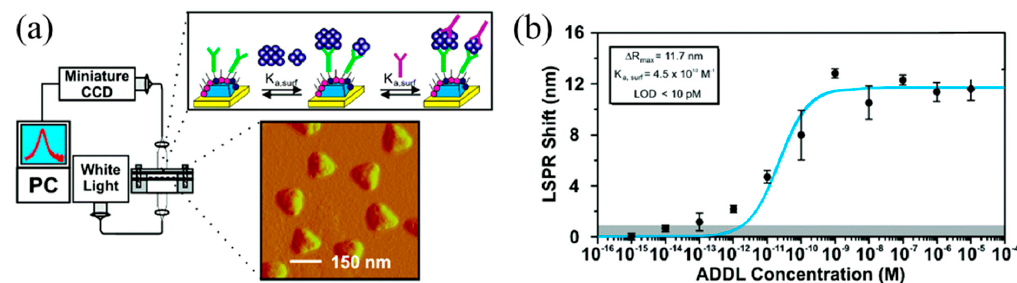
Figure 5. ( a ) Sketch and experimental setup for localized surface plasmon resonance (LSPR) based sensors and ( b ) some experimental results of amyloid- β derived diffusible ligands (ADDLs) detection. Reproduced from reference [81] with permission from American Chemical Society.